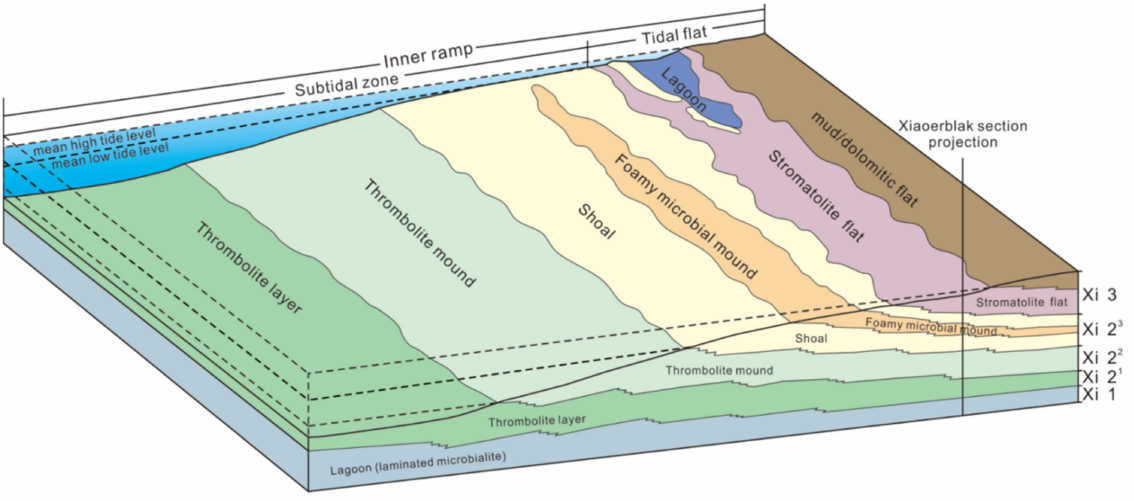
Figure 9. Sedimentary model of Xiaoerblak Formation in the study area. Xi 1, Xi 2 and Xi 3 are three members of Xiaoerblak Formation; Xi 2 1 , Xi 2 2 and Xi 2 3 are three submembers of member Xi